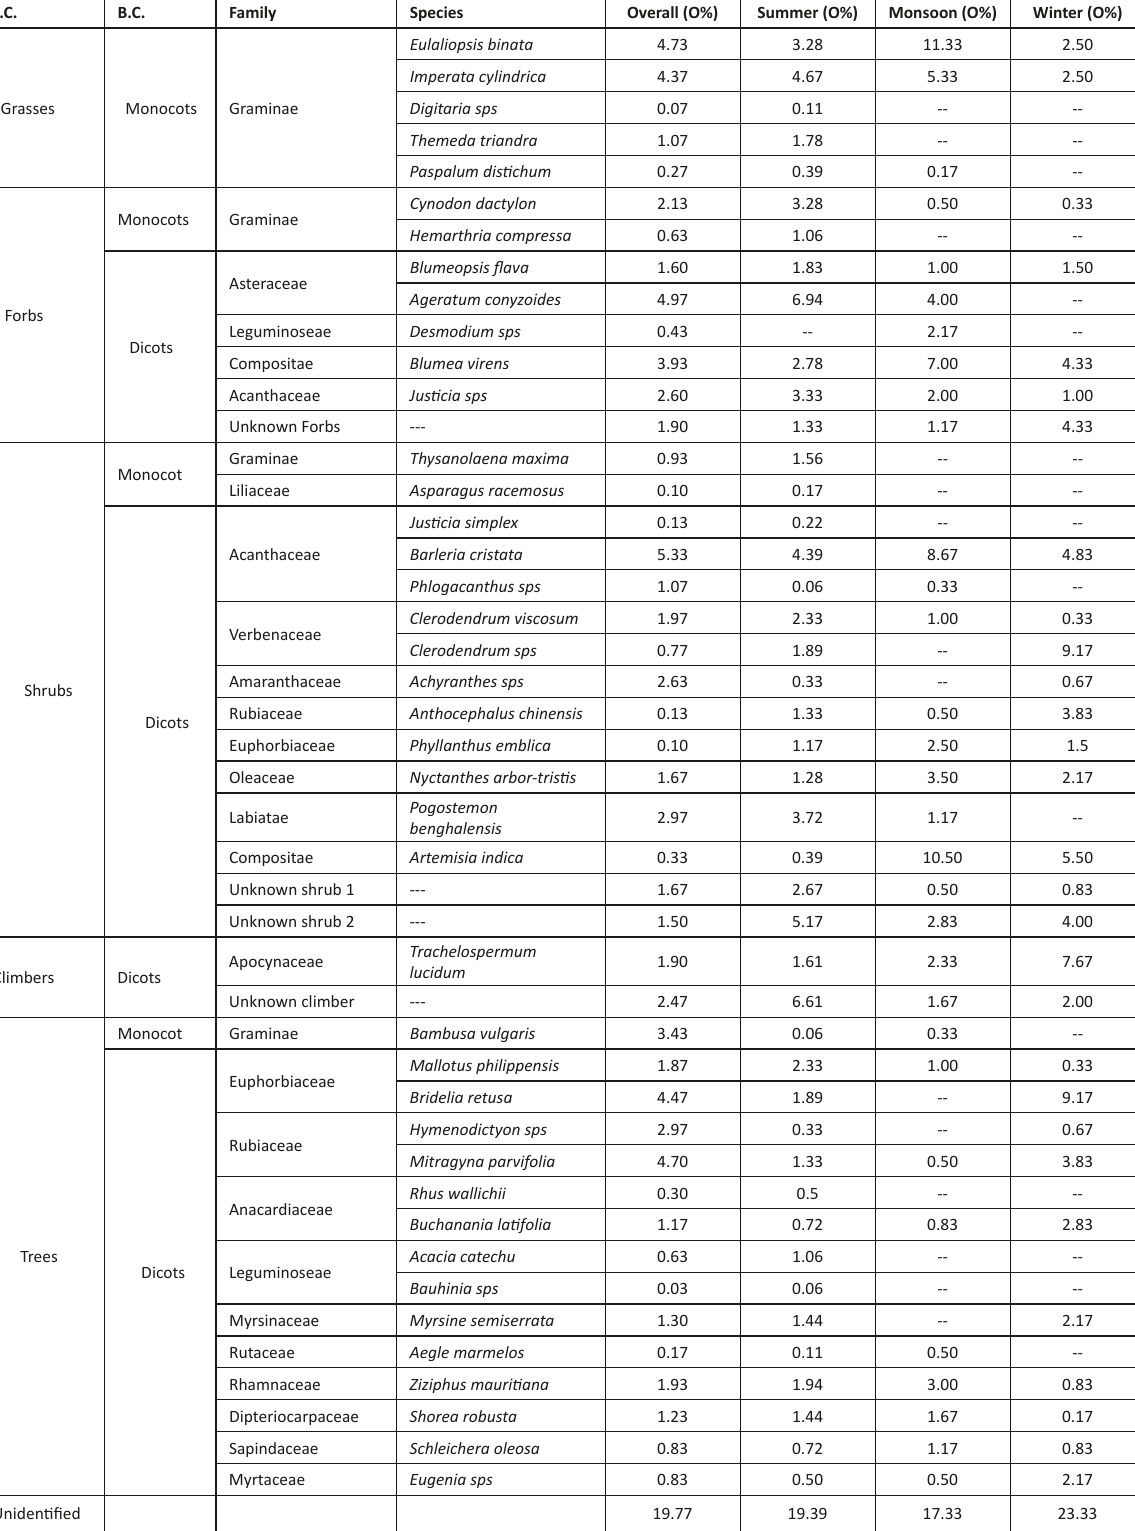
Table 1. Percentage composition (O%) of various plant categories (F.C. = Functional category; B.C. = Broad category, family and species) identified in pellets of Four-horned Antelope in BNP, Nepal.